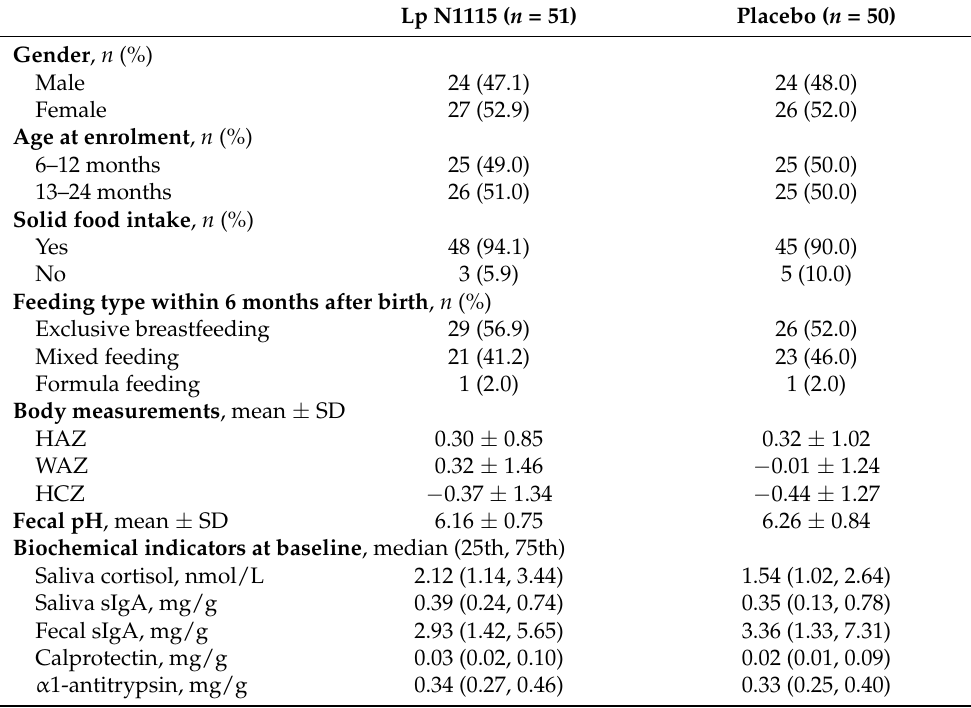
Table 1. Study population